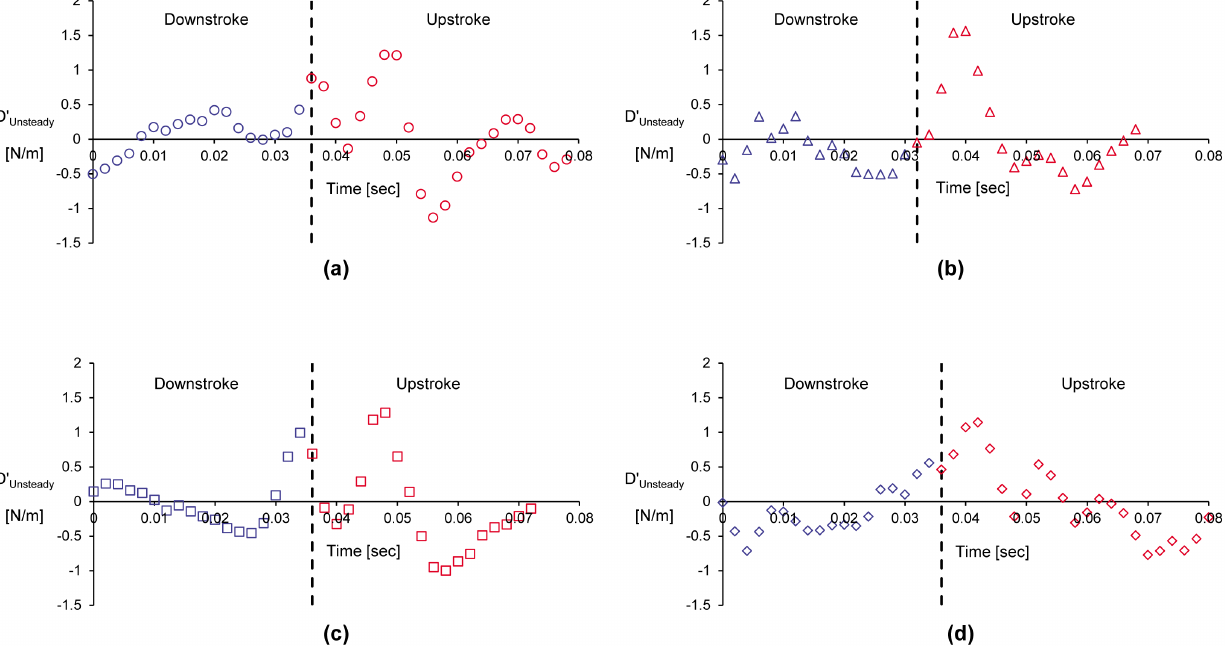
Figure 12. Unsteady drag per unit span versus time, as computed according to Eq. (11), for wingbeats no. 1 (a), 2 (b), 3 (c) and 4 (d).